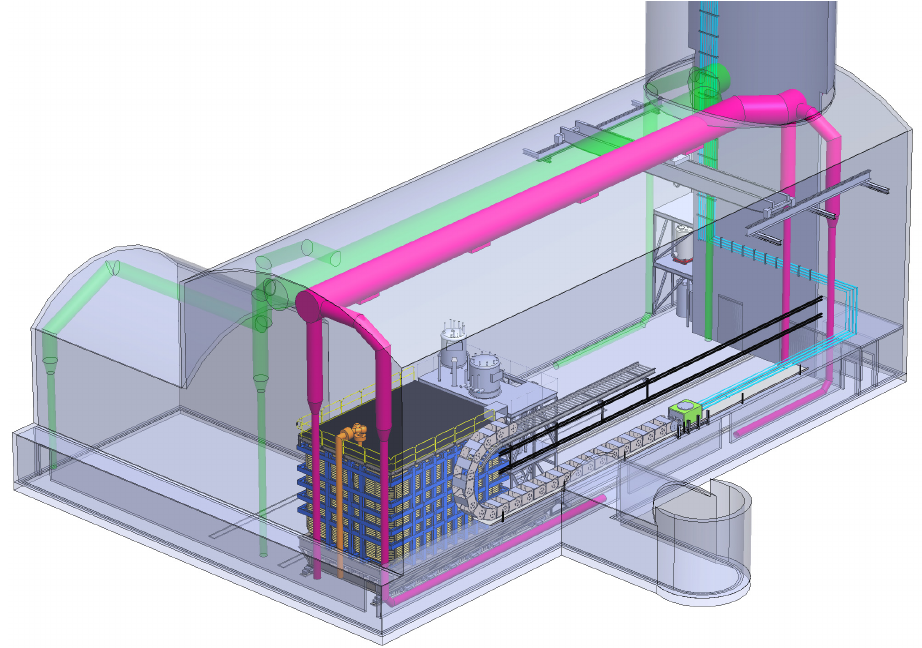
Figure 183. Conceptual routing of the ODH ventilation ducts (the supply line is in green and the exhaust line is in dark pink) inside the Near Detector cavern. Only the LAr detector is shown for clarity. The exhaust line must be directed to the bottom of the cavern to be able to collect argon gas along the travel path of the ND-LAr detector. The large ventilation ducts will be routed through the main shaft to the surface building mechanical equipment room (see Figure